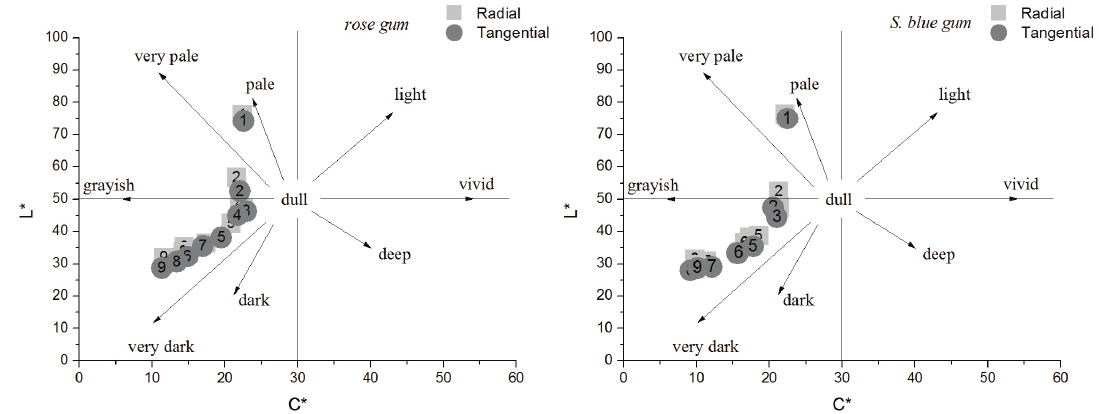
Figure 4. L* vs C* diagram for rose gum and Sydney blue gum untreated and thermally treated